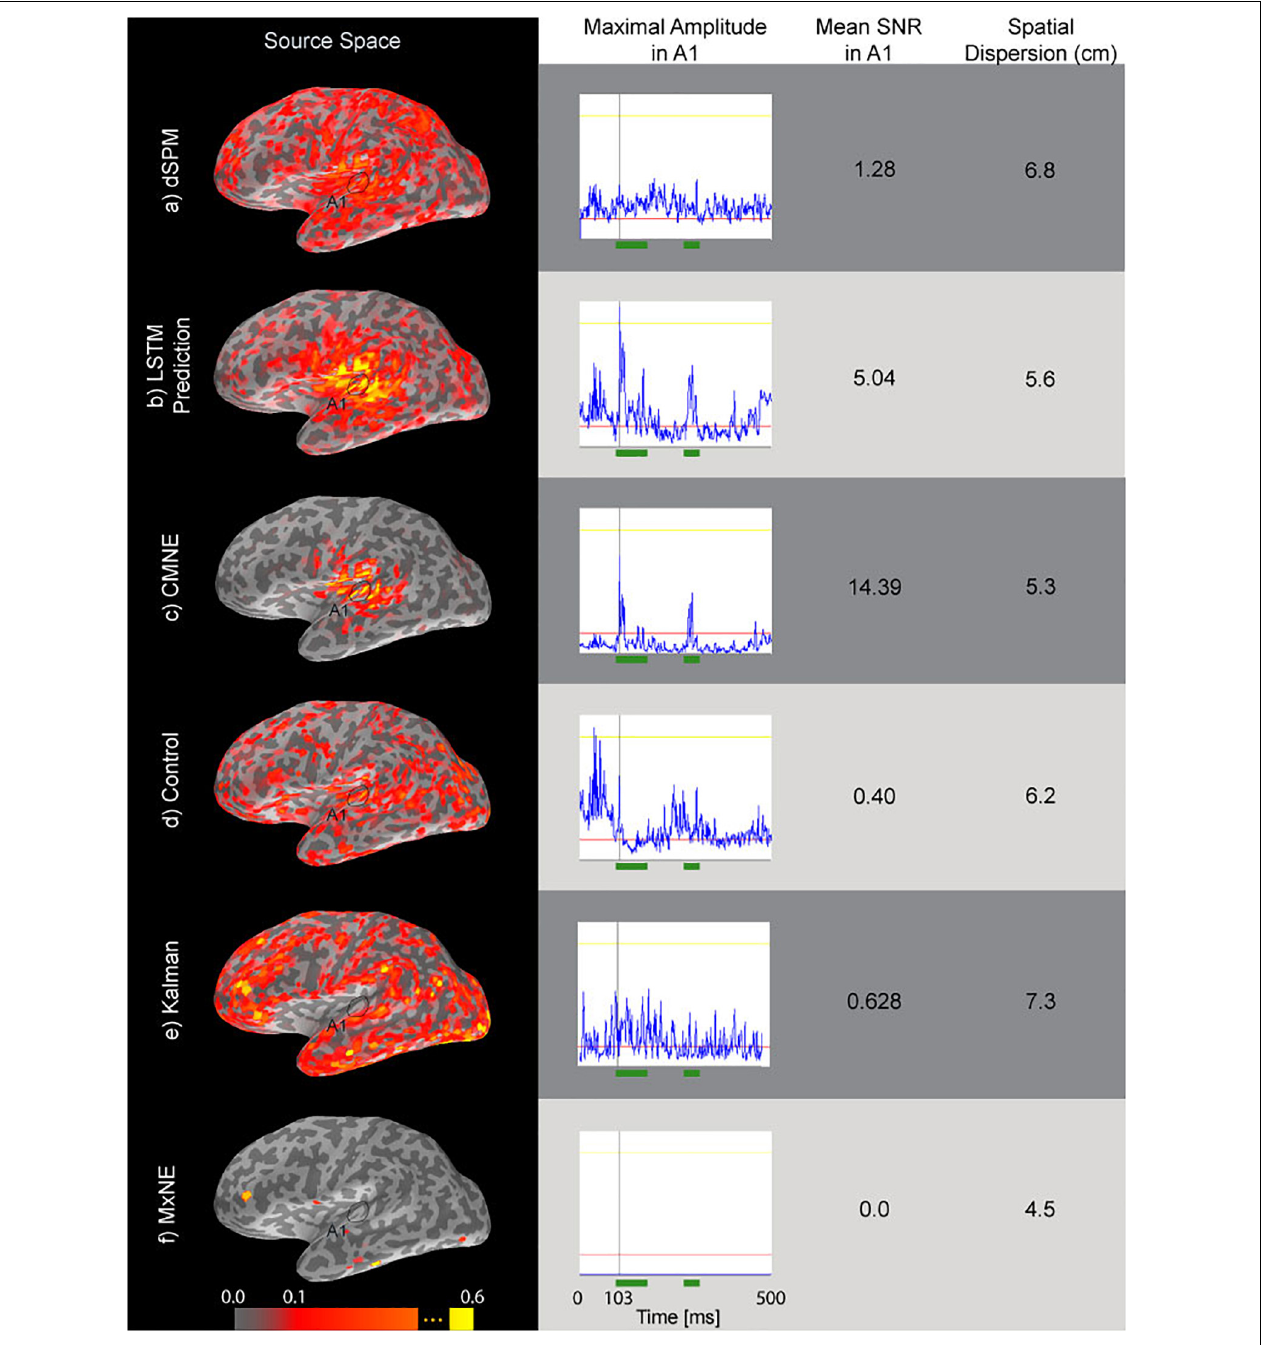
FIGURE 7 | Source estimates (first column) of ASSR data based on averages of 20 epochs, time courses (second column) of the source dipole in A1 with the greatest amplitude over the evoked response, SNR (Eq. 26, third column) and spatial dispersion (Eq. 24, fourth column) of the estimates. The green segments in the time courses mark the N1 and P2 responses that were used in the calculation of SNR (Eq. 26). The rows correspond to dSPM (a) , LSTM prediction (b) , CMNE (c) , control estimate (d) , Kalman estimate (e), and MxNE (f) . All estimates were rectified and normalized to their peak